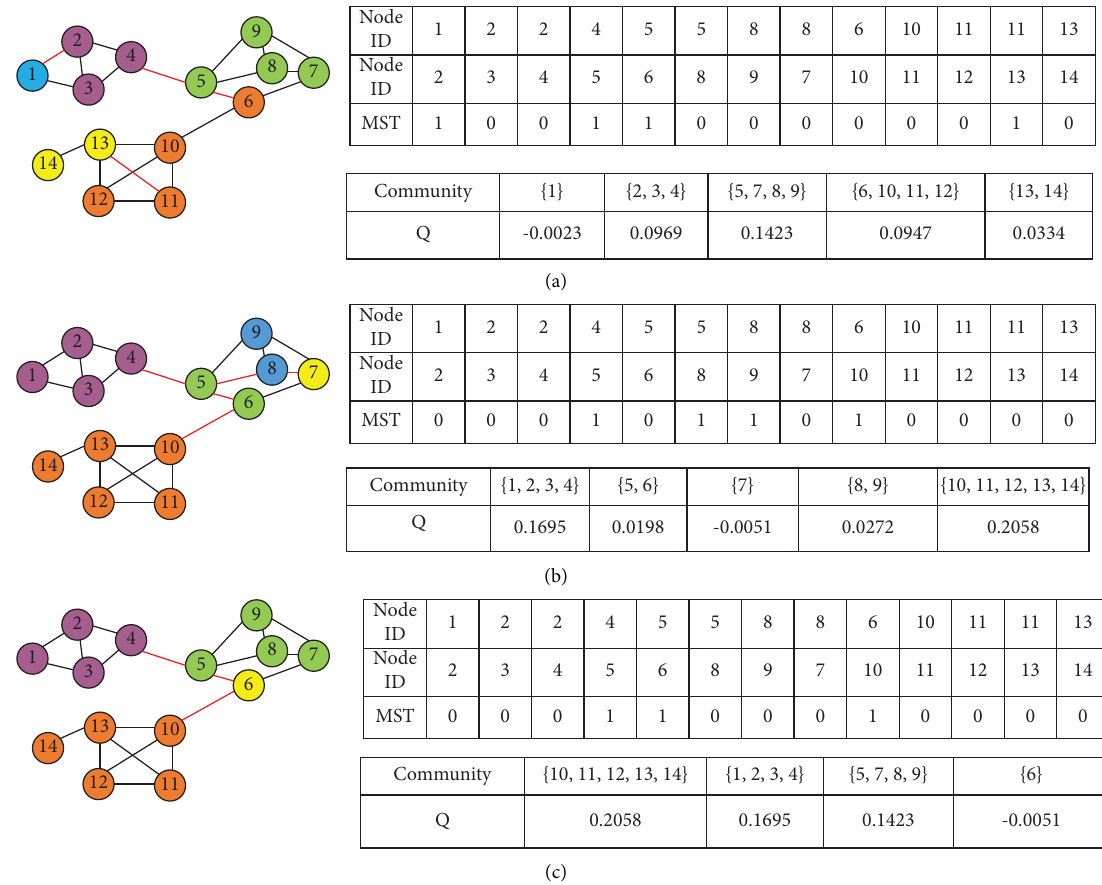
Figure 3: Te crossover procedure to create a new individual. (a) Te graph, individual, and community vector of the frst parent, (b) the graph, individual, and community vector of the second parent, and (c) new individual, to create the new individual frst, we sort the communities of both parents in descending order of their modularities; then, we select the communities from best to worst, respectively. Te C , C , and C communities get added frst. Ten, C gets selected, but because #10, #11, and #12 nodes are already assigned to other 2 , 5 2 , 1 1 , 3 1 , 4 communities, and a new singleton community gets formed for node